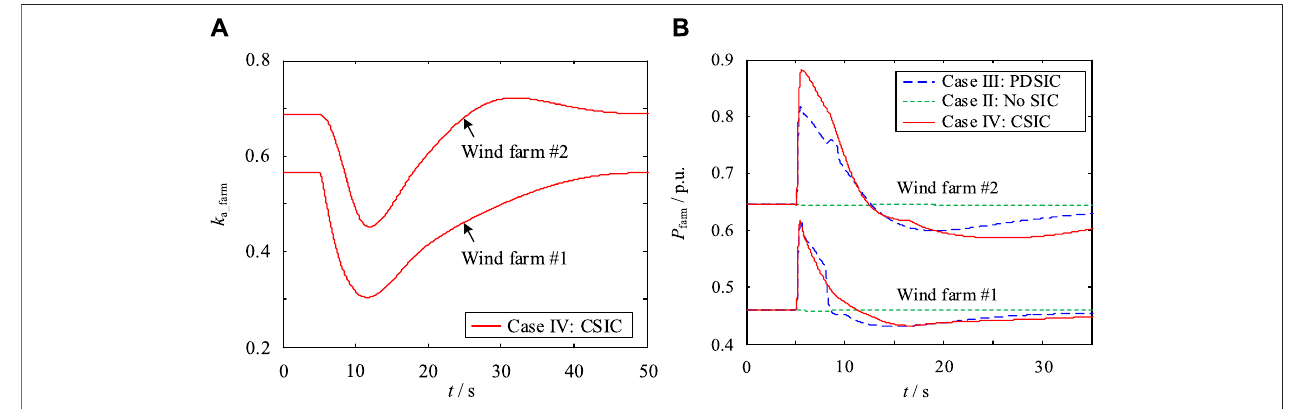
FIGURE 10 | Response characteristics of two wind farms: (A) FR capability coef fi cient; (B) output power (PB (cid:1) 180 MW).